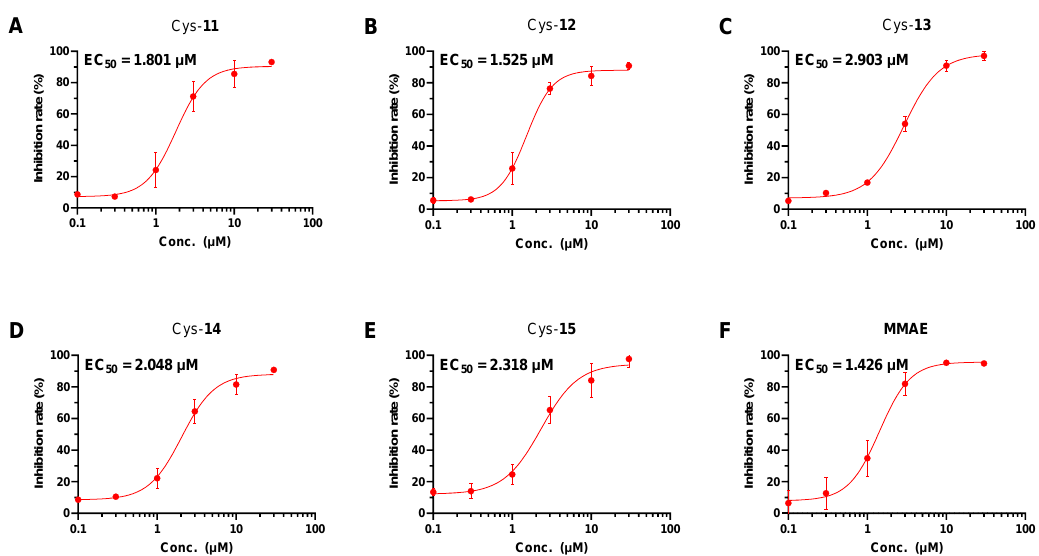
Figure 2. Tubulin polymerization inhibition analysis. ( A ) Cys- 11 , ( B ) Cys- 12 , ( C ) Cys- 13 , ( D ) Cys- 14 , ( E ) Cys- 15 and ( F ) MMAE were all tested at a range of concentrations (0.1, 0.3, 1.0, 3.0, 10.0, and 30.0 µ M), and the inhibitory activity of tubulin polymerization is expressed as the concentration for 50% maximal effect (EC 50 ). The results are shown as the mean ± standard deviation (SD) from triplicate experiments.